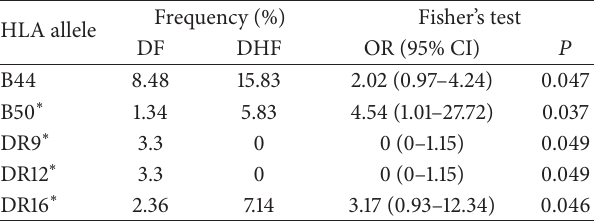
Table 4: Results of two-sided Fisher’s test of association between the HLA alleles analyzed and the clinical manifestations of dengue (DHF versus